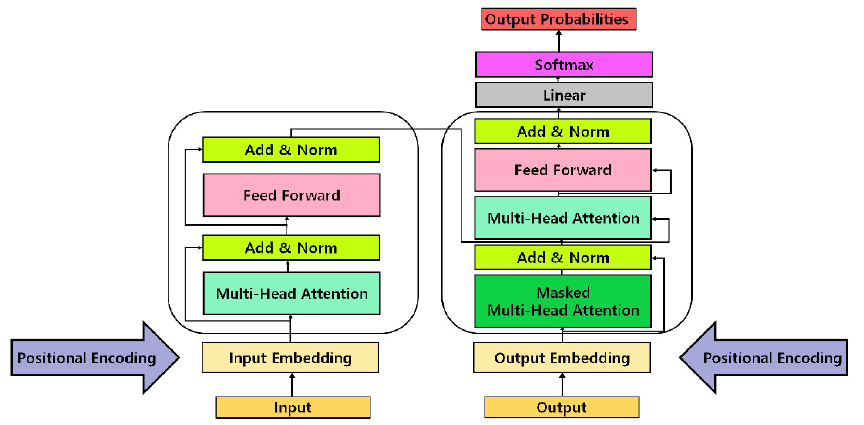
Figure 7. Structure of Transformer